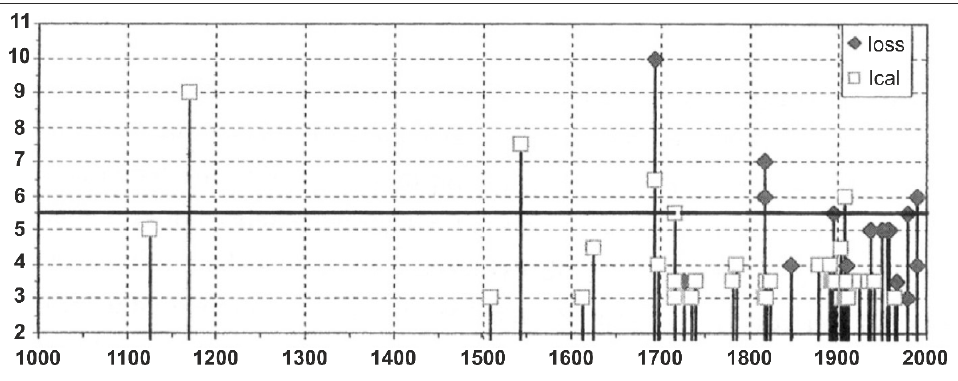
Figure 2. Seismicity of Ragusa over the last millennium, referring to Modified Mercalli Intensity Scale (MCS) Intensity values I observed I oss and the calculated ones I cal .